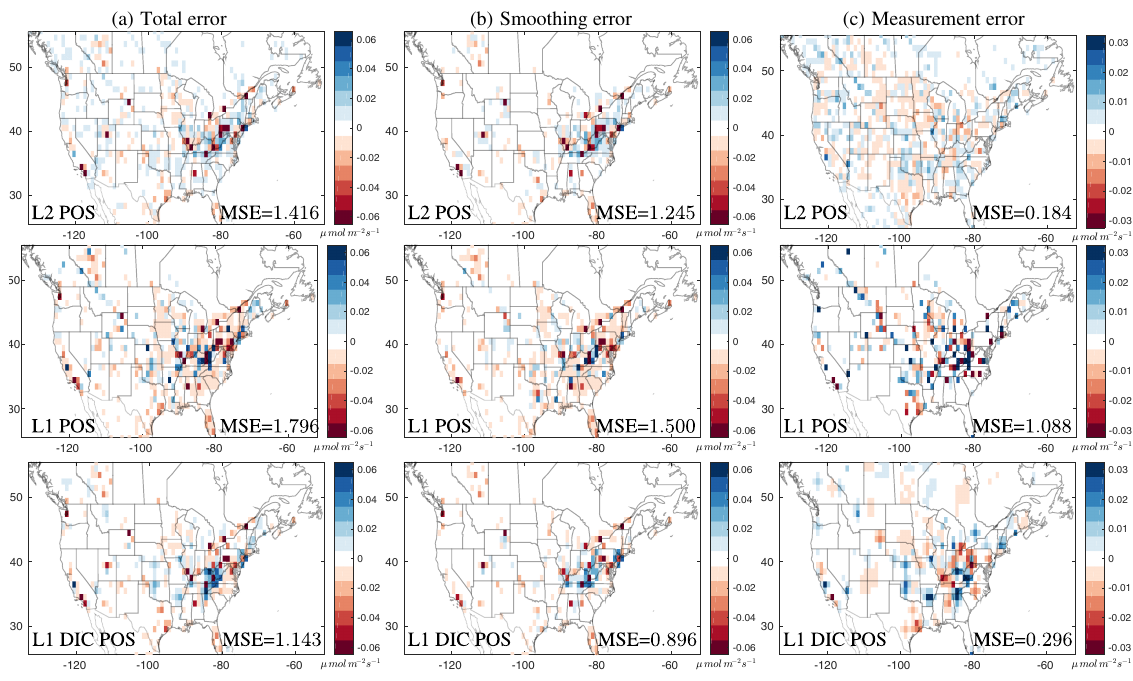
Figure 9. Total (a) , smoothing (b) , and measurement error (c) for methods L2 POS, L1 POS, and L1 DIC POS. Underestimation is col- ored in red, whereas blue colors represent overestimation. The mean squared error (MSE) calculated for each panel is given in 10 − 4 (µmolm − 2 s − 1 ) 2 . Note that the color coding is different for the measurement error.